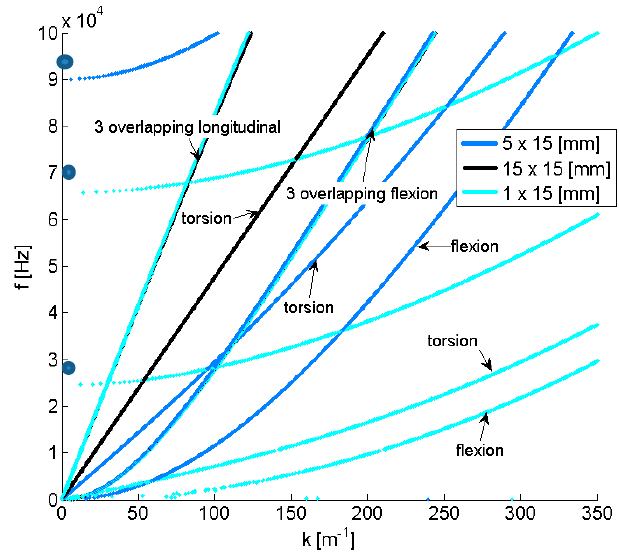
Figure 15. Scattering curves of three different sections height × width. (The blue dots in the graph indicate no fundamental modes). Notice that in this graph the wave number is defined as k = 2 π / λ [m -1 ].